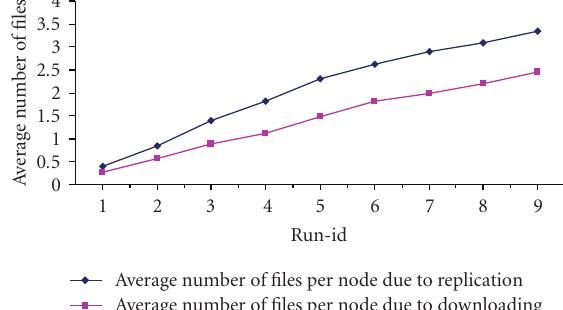
Figure 8: Number of files due to Q-Replication and Downloading.